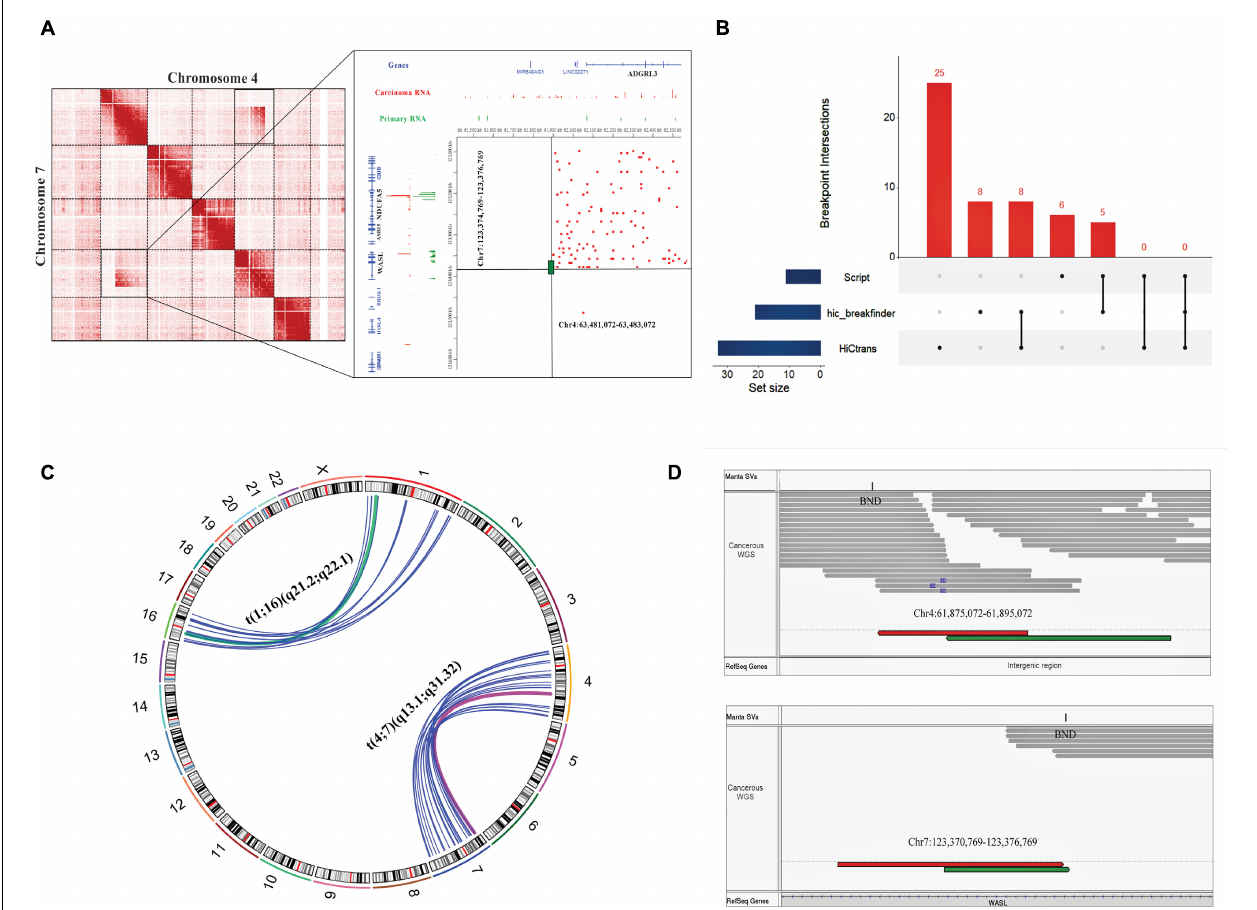
FIGURE 3 | Hi-C and WGS results showing the consistency of translocations detected in cervical cancer samples. (A) Magnified representation of translocated regions observed by visual observation (left panel), while the right panel (zoomed snapshot) represents the Hi-C breakpoints between chromosome 7 and chromosome 4 detected by in-house script at highest resolution. Red peaks show cervical cancer RNA, while green color indicates the normal RNA sequence. Reference genes are highlighted with black color. (B) UpSet plot of breakpoints results detected by different methods. In the bottom left panel, blue horizontal bars represent the number of translocations detected by each method; vertical red-colored bars represent the size of breakpoint intersections of each translocation sets. Black dots show the sample set, and the intersection between methods is represented by a vertical black line. This graph is generated by UpSetR package. (C) Circos plot representing the chromosomal rearrangements between chr1, chr4, chr7, and chr16 detected by Hi-C and WGS. Deep pink- and green-colored arcs show the overlapped results of Hi-C and WGS, while blue color represents WGS-based translocations. (D) The translocation event between t (4;7) (q13.1; q31.32) in cervical cancer data visualized by IGV tool, showing WGS paired reads supporting the translocation results of Hi-C data. Breakpoints are labeled by “BND” in the upper panels of both IGV windows. Upper IGV window represents Chr4 reads, and the lower window shows Chr7 reads. Green and red colors depict the first and second read of